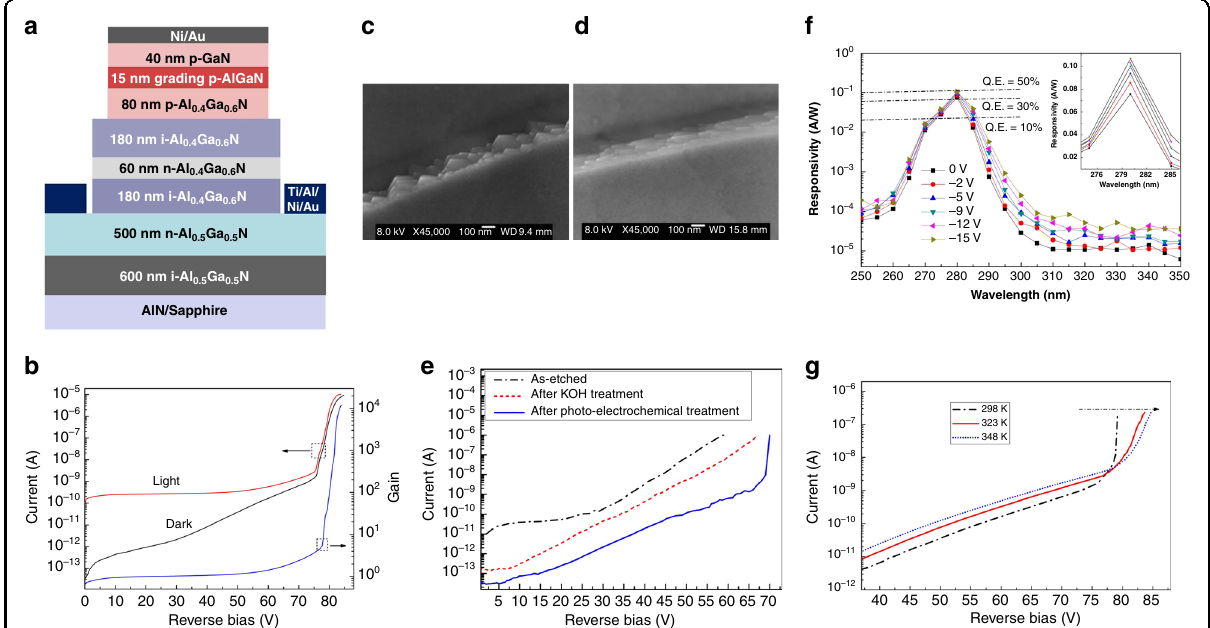
Fig. 14 Structure and performance of an AlGaN SAM APD. a Schematic cross-sectional diagram of the SAM AlGaN APD. b I-V curve in dark and under illumination. Sidewall SEM images of APD with KOH ( c ) and photo-electrochemical ( d ) treatment, respectively. e Dark currents for samples with different treatments. f Spectral response at various applied voltages. g Dark currents at various temperatures. Reprinted with permission from Shao et al. 224 . Copyright 2014